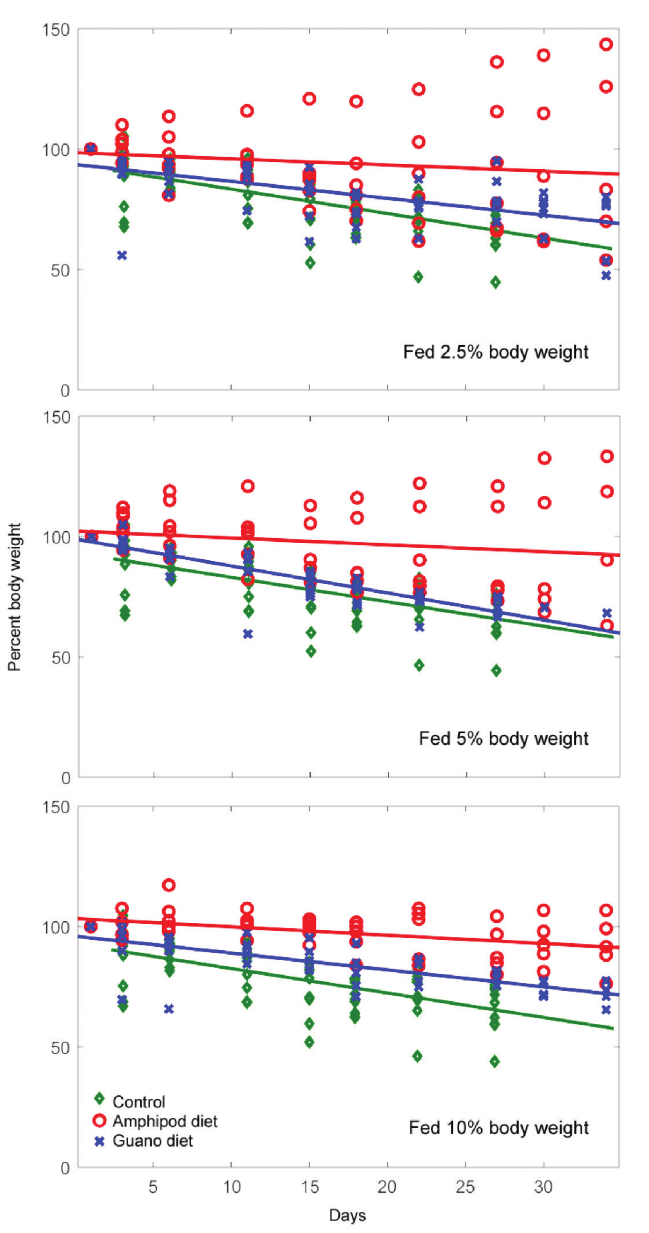
Figure 2. Regression lines based on body mass loss of different diet types and amounts. Salamanders were fed nothing (green), live amphipods (red) or guano (blue). Groups were fed every four days based on their initial body weight, with 2.5% ( A ), 5% ( B ) or 10% ( C ). The calculated regression lines were as follows: Control -1.16x+96.01 R 2 = 0.54, n = 10; 2.5% -0.26x+98.49, R 2 = 0.39, n = 6; 2.5% amphipod guano -0.70x+93.58, R 2 = 0.02, n = 6; 5% -0.28x+102.22, R 2 = 0.03, n = 6; 5% -1.12x+98.89, R 2 amphipod guano = 0.77, n = 6; 10% -0.35x+103.36, R 2 = 0.21, n = 6; 10% -0.70x+96.01, R 2 = 0.53, n = amphipod guano